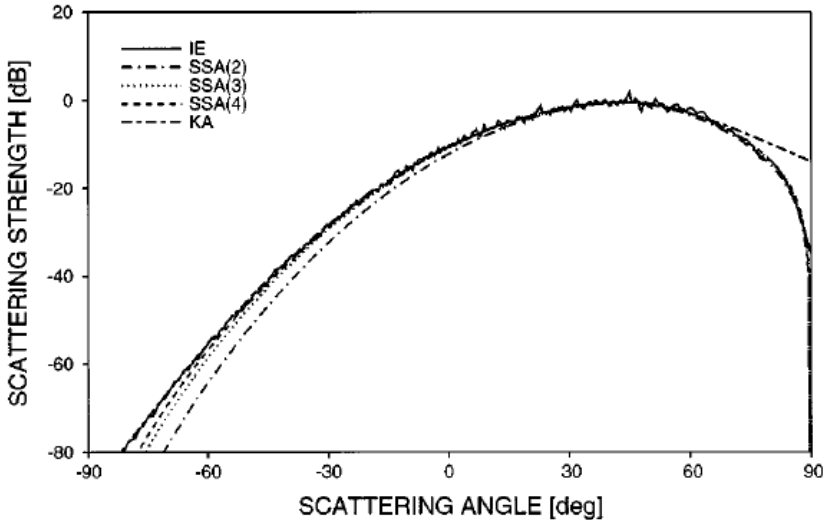
Figure 10. Thorsos’ Figure 3 [112]. Comparison of SSA(2), SSA(3), SSA(4), Kirchhoff approximation (KA) and IE scattering strengths. Here k σ = 1.5, kL = 12.0, γ is 10 ◦ and θ i is 45 ◦ . Reproduced with permission from [112], AIP Publishing, 1997.